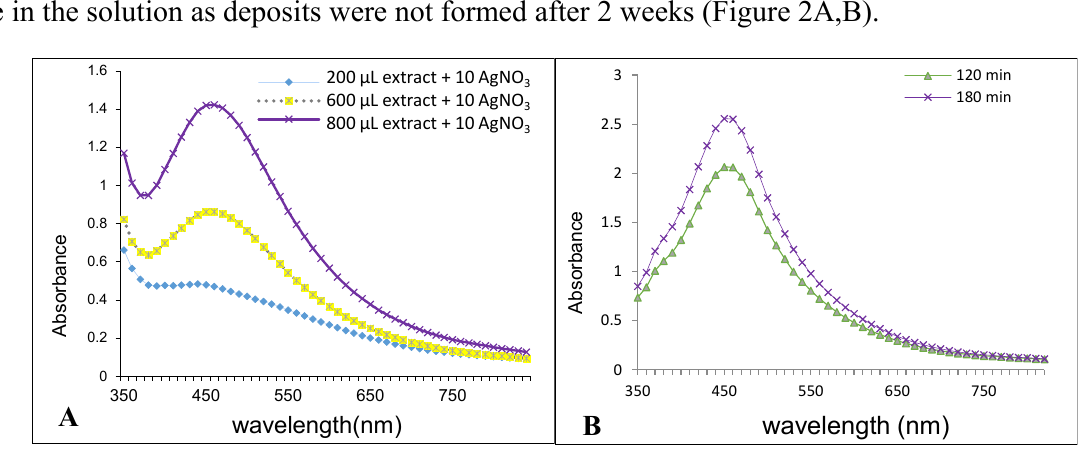
Figure 2. UV-visible spectra of the Ag-NPs synthesized with different volumes of plant extract at 180 min ( A ) and UV-visible spectra of the green synthesized Ag-NPs at different times ( B